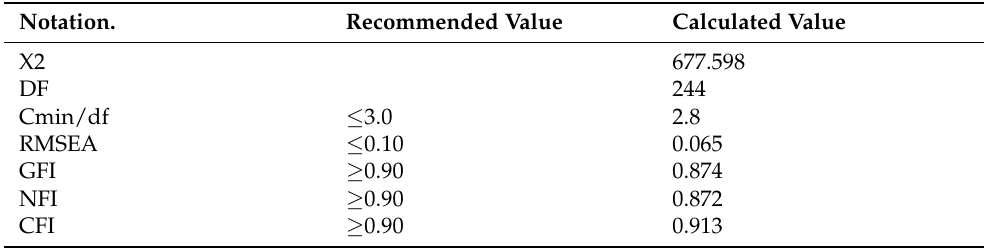
Table 3. Results of testing the model fit.